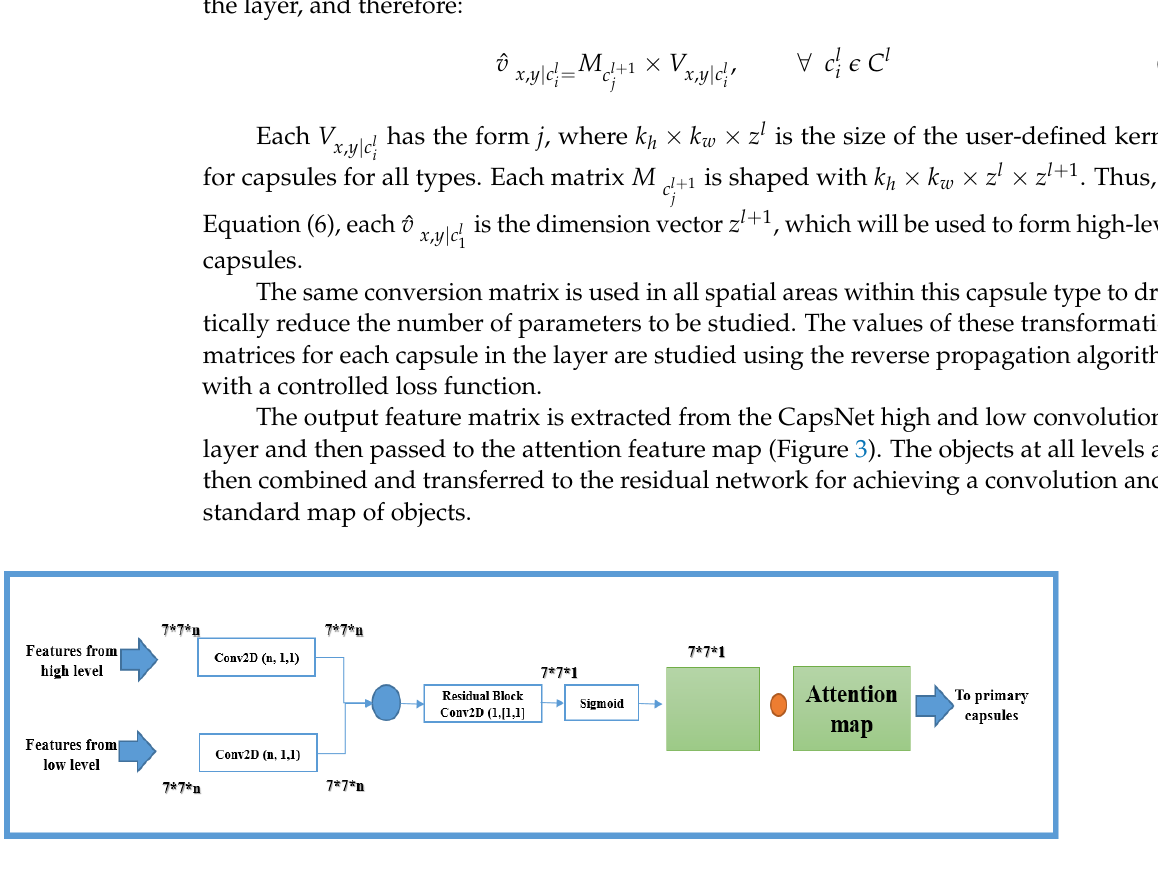
Figure 3. Attention feature map.